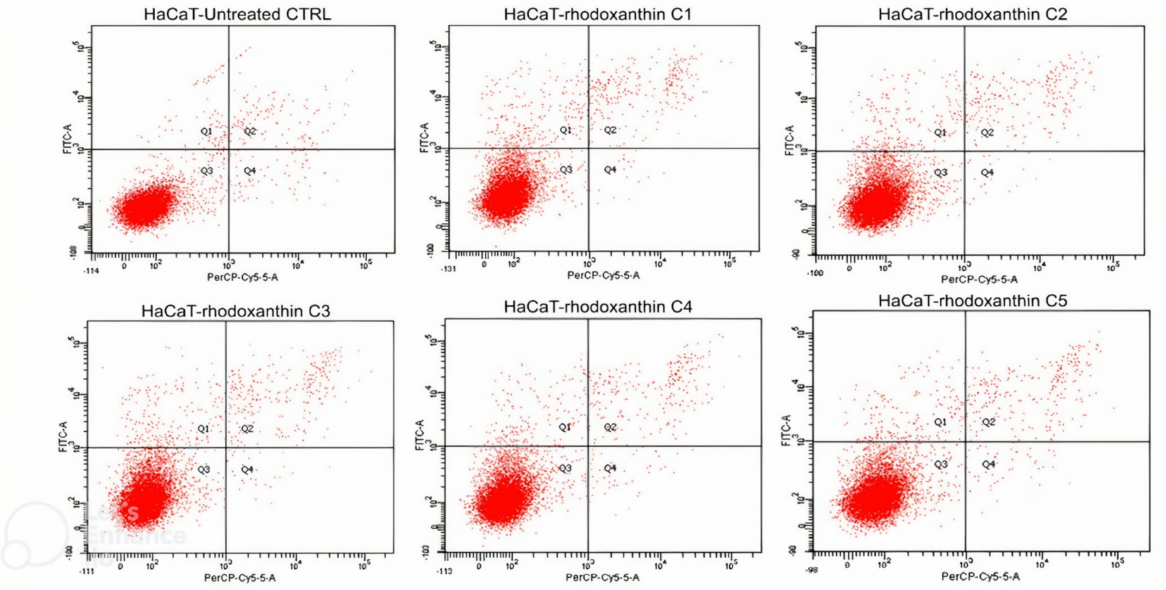
Figure 6. Analysis by flow cytometry of the viability of the HaCaT cell line treated with rhodoxanthin (Q1 = cells in early apoptosis, Q2 = cells in late apoptosis, Q3 = viable cells, and Q4 = necrotic cells). Values represent the mean ± SD of three samples (C1—0.18 µ mol/mL, C2—0.13 µ mol/mL,